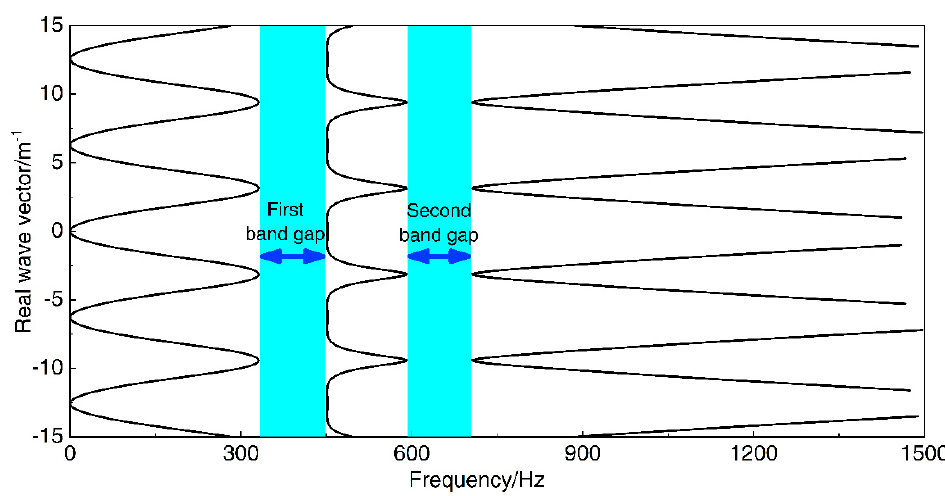
Figure 2. The flexural wave vibration band gaps structure of the proposed infinite long periodic oscillator coupled damping oscillator coupled damping beam.